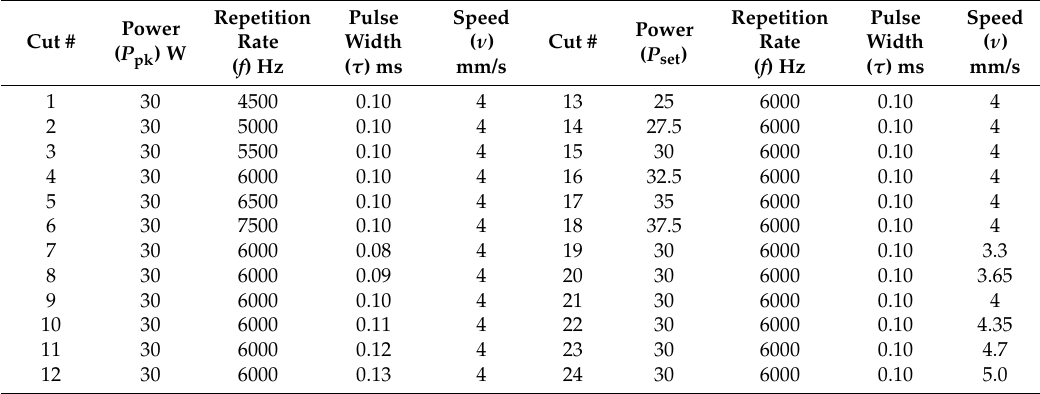
Table 3. Process parameters for Set